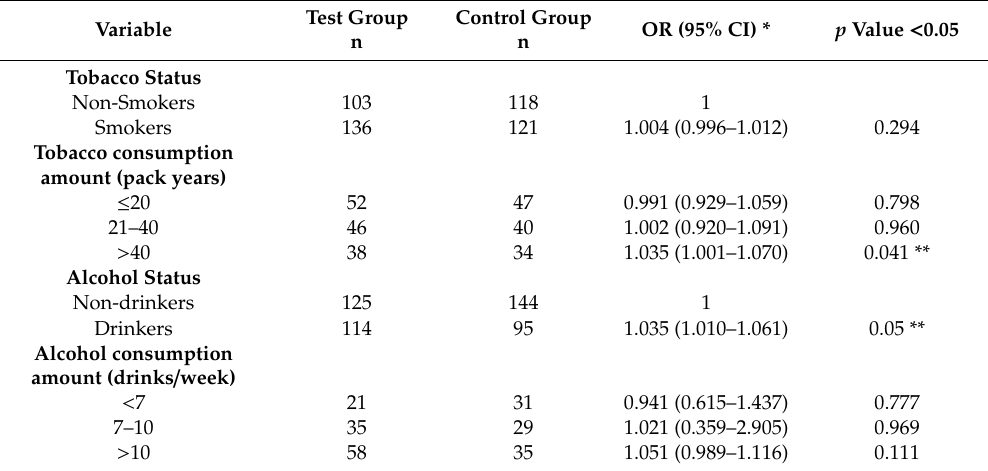
Table 4. Odd Ratios (ORs) for tobacco and alcohol.